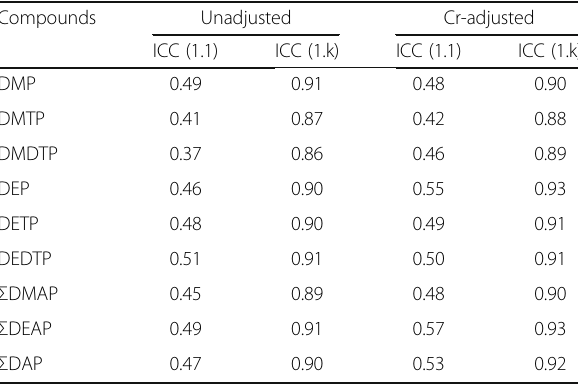
Table 2 Unadjusted and Cr-adjusted ICCs of urinary OP metabolites Compounds Unadjusted